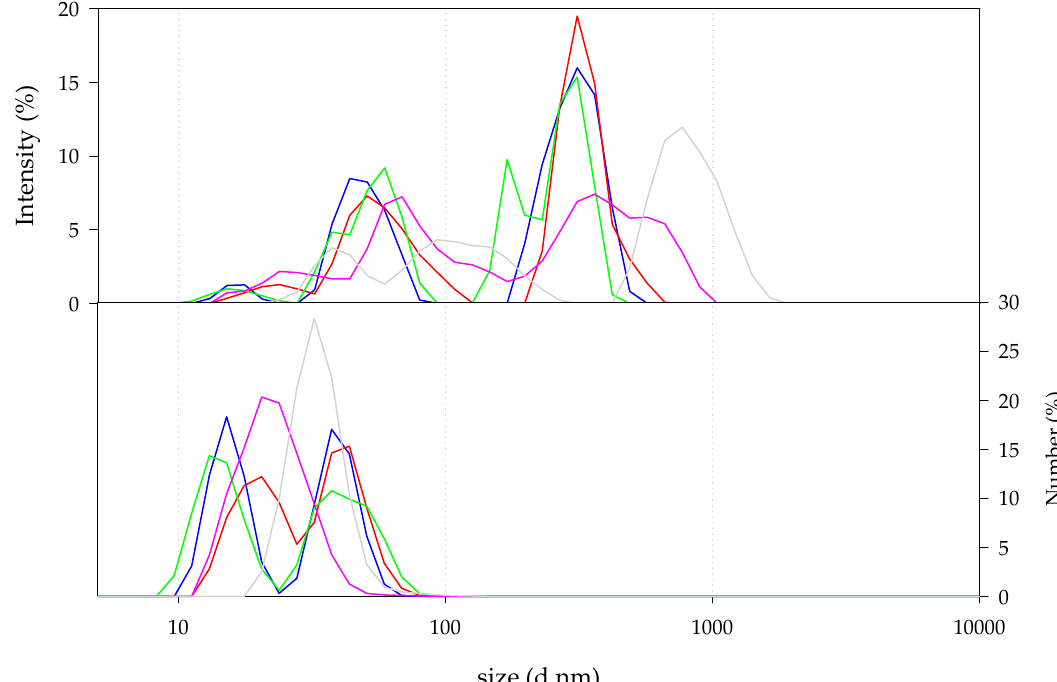
Figure 1. Hydrodynamic diameter of mucin type III from Sigma-Aldrich at 1.25 (blue), 0.625 (red), 0.313 (green), 0.156 (pink), and 0.078 mg / mL (grey). Size distribution by intensity ( top ) and by number ( bottom ).